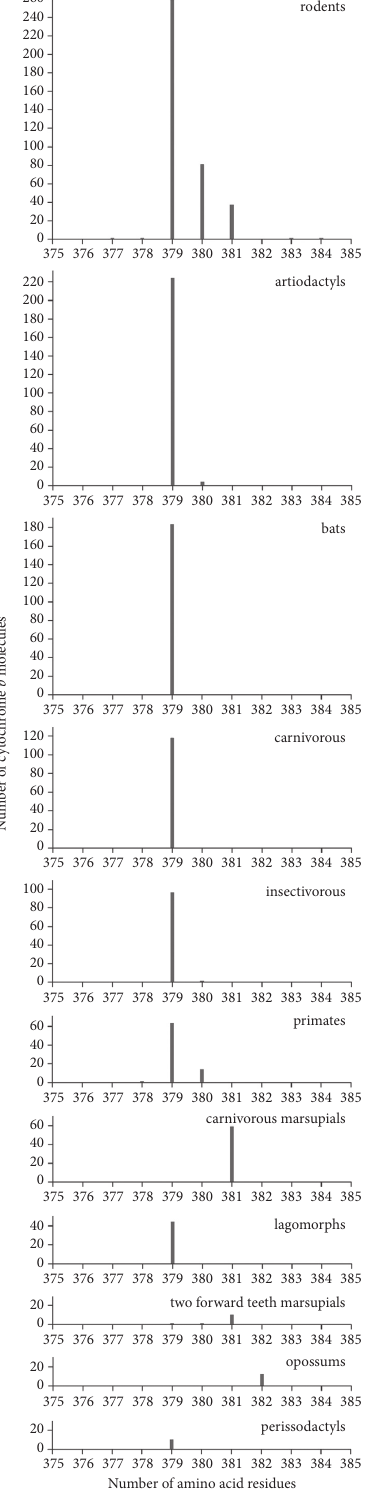
Figure 6: Distribution of the number of cytochrome b molecules, according to data from the Swiss-Prot database on the number of amino acid residues in various biological